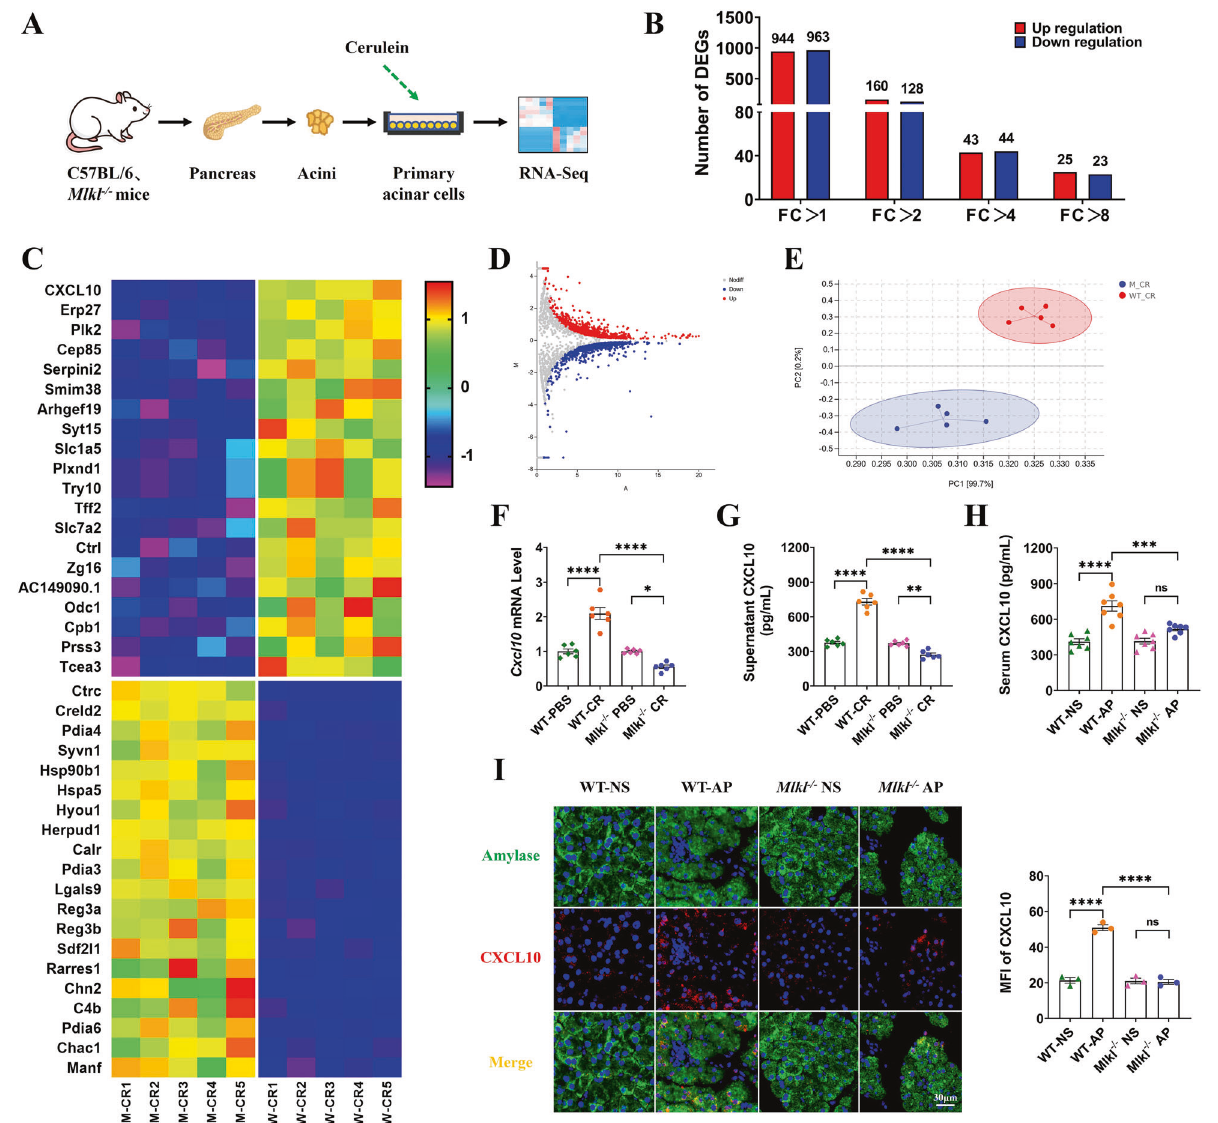
Fig. 6 RNA sequencing was performed to identify the differentially expressed genes between WT and Mlkl -/- mouse-derived, cerulein- treated pancreatic acinar cells. CXCL10 was the most signi fi cantly upregulated gene in pancreatic acinar cells from WT mice and was validated in cell and animal experiments. A Schematic diagram for preparing samples for RNA sequencing. B Number of differentially expressed genes (DEGs) at different fold changes. C Heatmap of the top 20 upregulated and downregulated genes. D Volcano plot of DEGs. E PCA plot. F mRNA levels of Cxcl10 in pancreatic acinar cells isolated from WT and Mlkl -/- mice. Data were normalized to GAPDH ( n = 6). G Levels of CXCL10 in the supernatant of pancreatic acinar cells isolated from WT and Mlkl -/- mice ( n = 6). H Serum CXCL10 levels in WT and Mlkl -/- mice ( n = 7). I Immuno fl uorescence staining of amylase (green) colocalized with CXCL10 (red) in the pancreas of WT and Mlkl -/- mice ( n = 3). Values are shown as the means ± SEMs. ns, not signi fi cant; * P < 0.05; ** P < 0.01; *** P < 0.001; **** P < 0.0001. WT wild type, NS normal saline, AP acute pancreatitis, CR cerulein, MFI mean fl uorescence